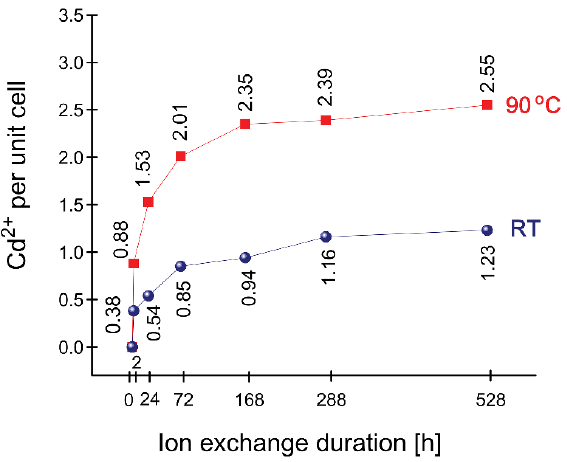
Figure 4. Exchanged Cd 2+ for different duration times and temperatures (EDS data).